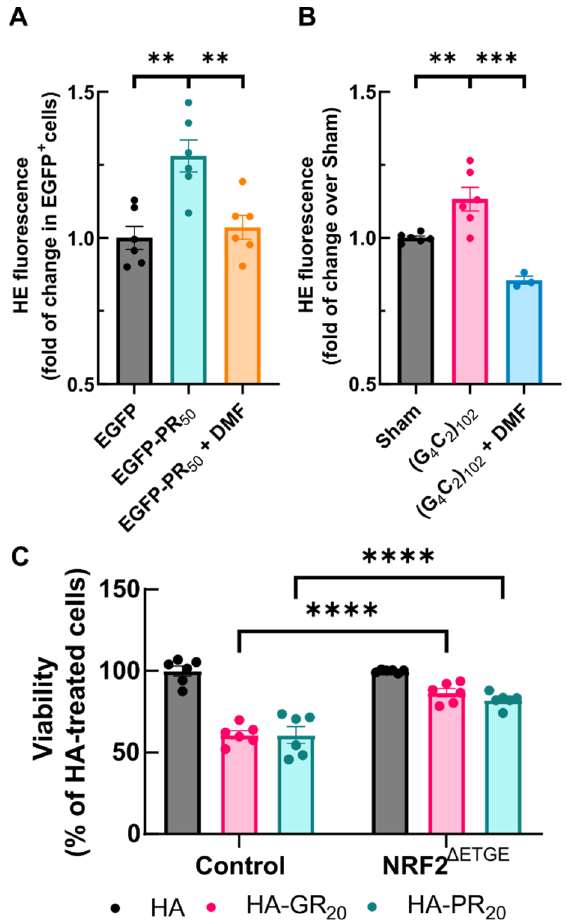
Figure 7. Activation of NRF2 rescues from DPRs toxicity. ( A , B ) NSC34 cells were transiently transfected with EGFP, EGFP ‐ GR 50 or EGFP ‐ PR 50 for 48 h or the expression of the Sham cassette or the (G 4 C 2 ) 102 cassette was induced for 7 days with 1 μ g/mL tetracycline in NSC34 cells, respectively. Cells were treated with either VEH (DMSO 0.1%) or DMF 100 μ M over the last 4 h and stained with 2 μ M hydroethidine during the last hour. Probe intensity was measured by flow cytometry analysis. In ( A , B ), each point depicts the geometric mean of probe fluorescence in cells from that sample ( A ), alive EGFP + cells, ( B ), all alive cells). ( C ) NSC34 cells were transduced with either control lentiviral particles or encoding the stable NRF2 version lacking the ETGE KEAP1 ‐ binding motif for 48 h and then treated with 6 μ M of HA, HA ‐ GR 20 or HA ‐ PR 20 peptides for 24 h. Cell viability was measured using a MTT assay Bar height indicates the mean of the whole group and error bars indicate the SEM. Statistical analysis was performed with one ‐ way ANOVA ( A , B ), Dunnett’s post ‐ hoc test or two ‐ way ANOVA ( C ), Bonferroni’s post ‐ hoc test. ** p < 0.01; ***, p < 0.001; ****, p < 0.0001.